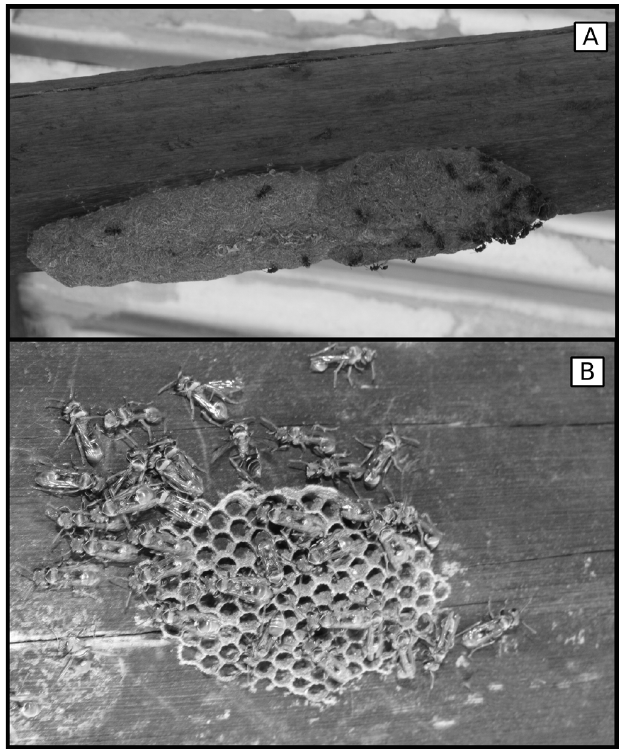
Fig 4 . Nest of Metapolybia fraudator from Brazil, Novo Airão, Amazonas: A = nest attached to the ceiling of a wood house; B = small cells of the new nest